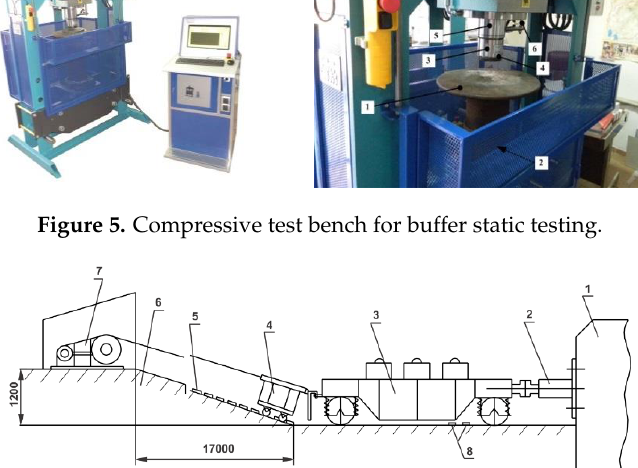
Figure 6. Testing buffer on a real railway model with impact.